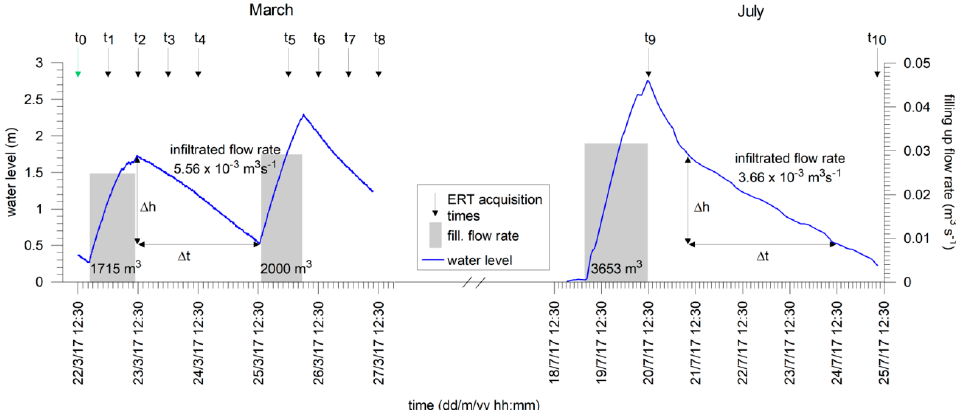
Figure 4. Water level recorded in March and in July in Trench 9. The filling-up flow rate, the duration of filling-up, and the total volumes of water introduced in the trench for each cycle are also shown. Black arrows indicate the electrical resistivity tomography (ERT) time points with respect to the time reference t 0 in green.